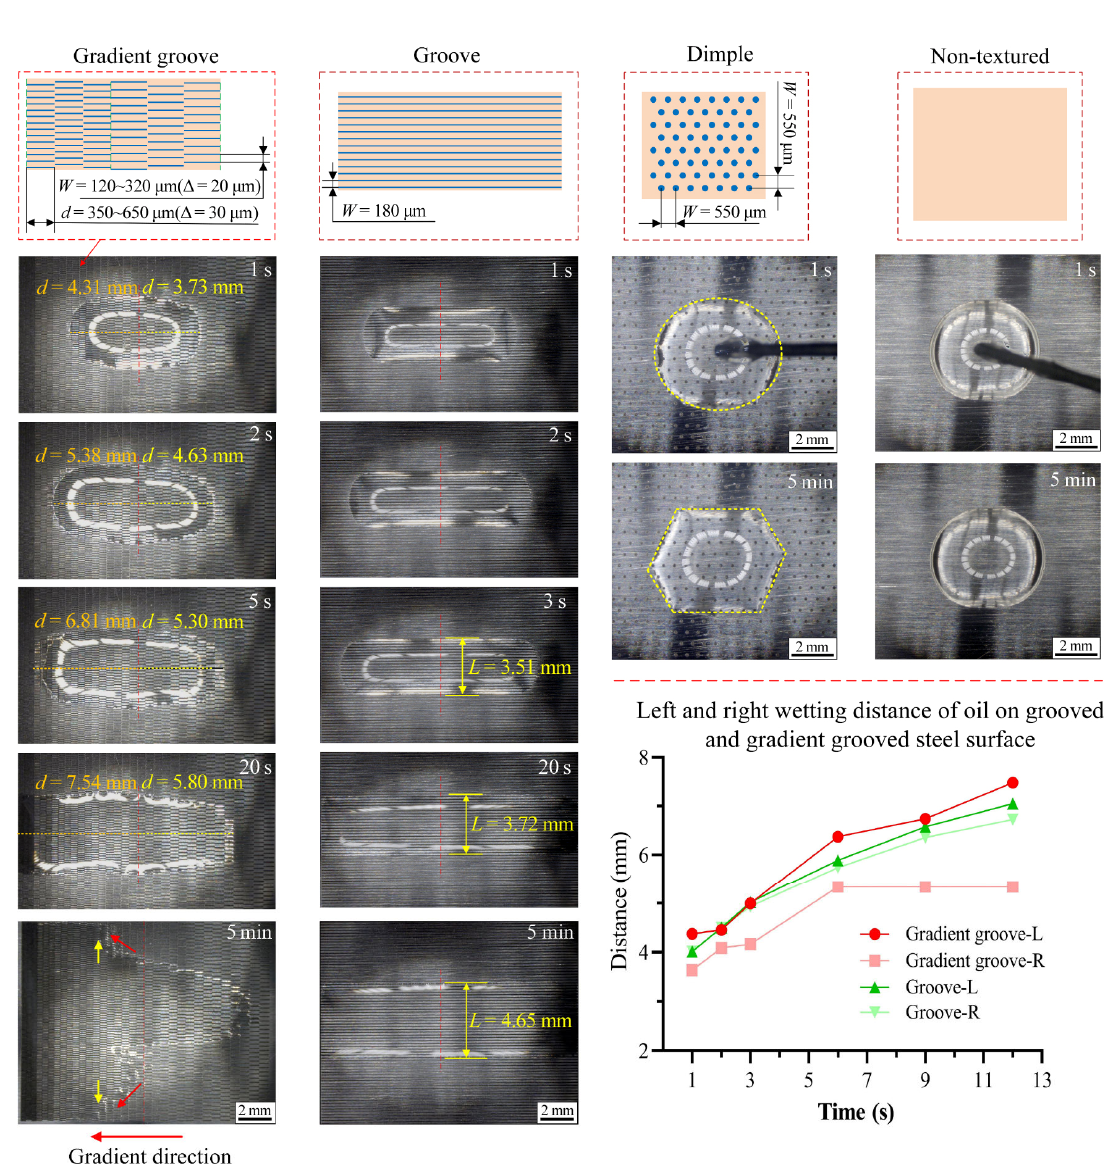
Fig. 7 Oil droplet spreading